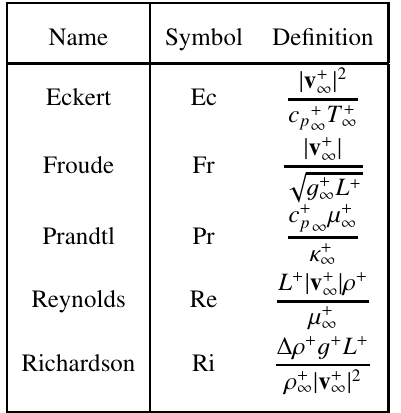
Table 1. Definitions of nondimensional numbers used in system (1). Note, that the Eckert number in this form belongs to temperature normalised by value T + instead of widely used ∞ characteristic temperature di ff erence ∆ T + . L + is a characteristic length, c + specific heat at constant pressure. p